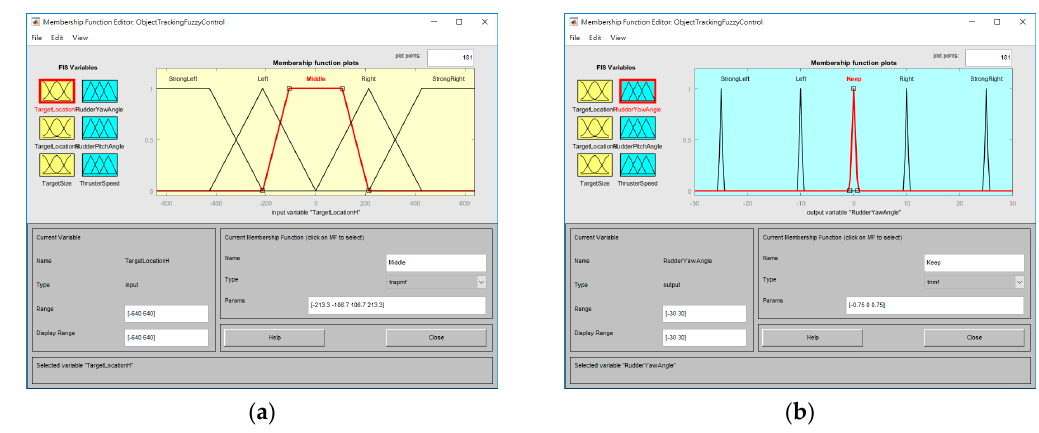
Figure 9. Interfaces of ( a ) the input variable of membership of the object on the visual plane (X-direction) and ( b ) the output variable of membership of the horizontal rudder angle.